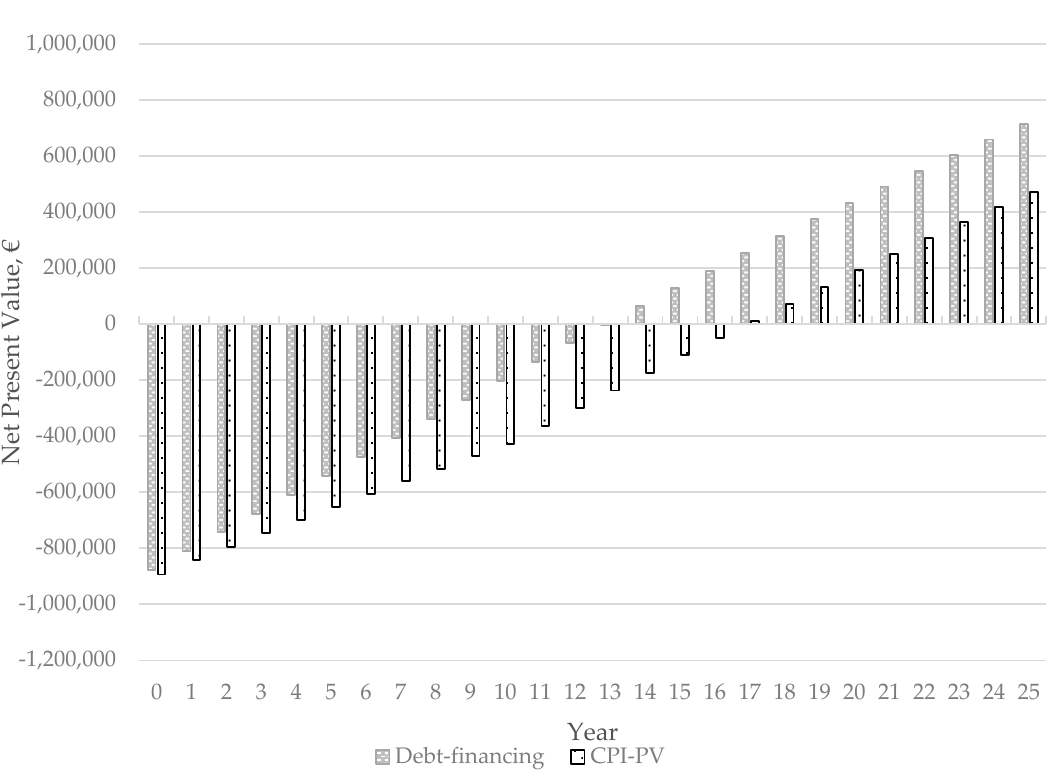
Figure 3. Net present value Case 2 lowest individual price for all companies.